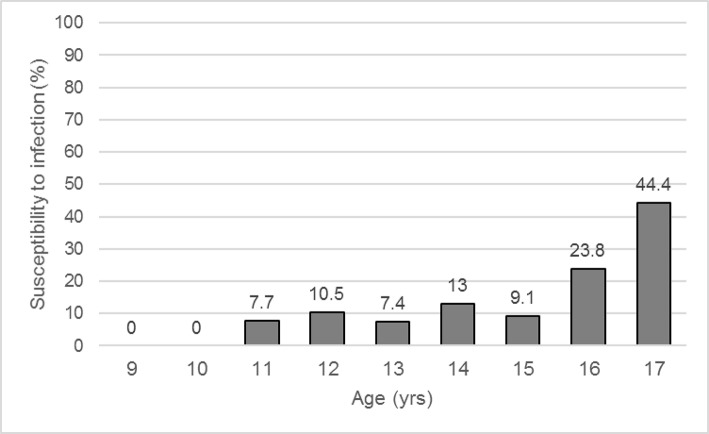
Prevalence of susceptibility to infection in athletes depending on age. Values are expressed as means.